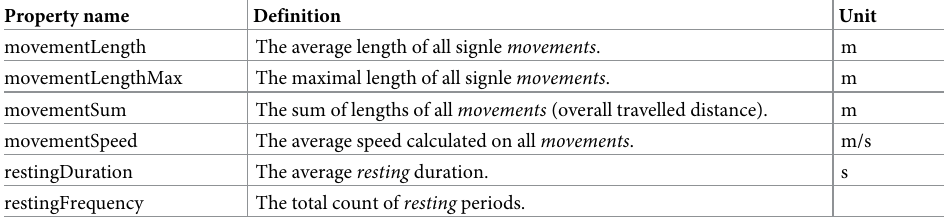
Table 3. Movement and resting properties that were calculated from the data. Property name Unit The average length of all signle movements . The maximal length of all signle movements . m The sum of lengths of all movements (overall travelled distance). m The average speed calculated on all movements . m/s The average resting